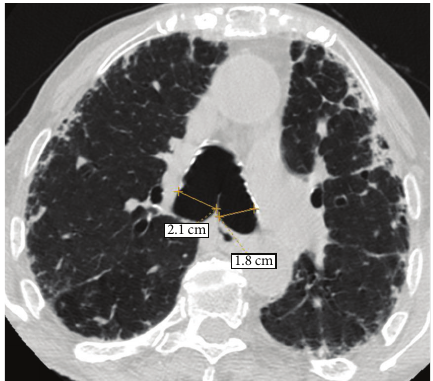
Figure 4: HRCT of the chest at the level of the carina. An enlarge- ment of the right and left main bronchi is observed measuring in axial dimensions 2.1cm and 1.8 cm, respectively. A subpleural reticular pattern associated with focal thickening of the pleura and traction bronchiectasis and bronchiolectasis is also noted.